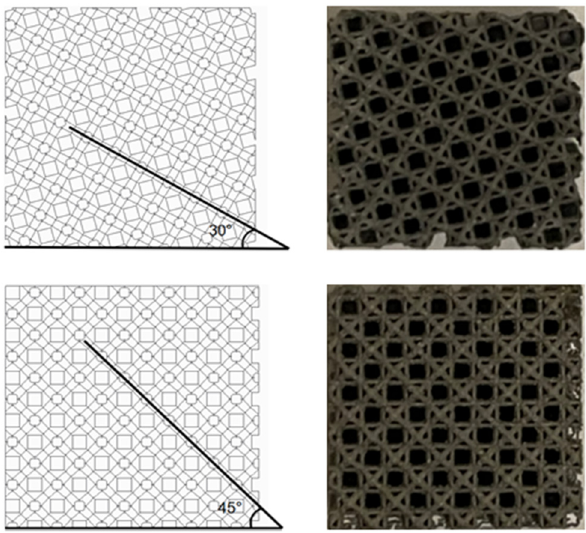
Figure 19: The 1.5 mm unit cell with 0.4 mm edge diameter is molded at di ff erent angles.